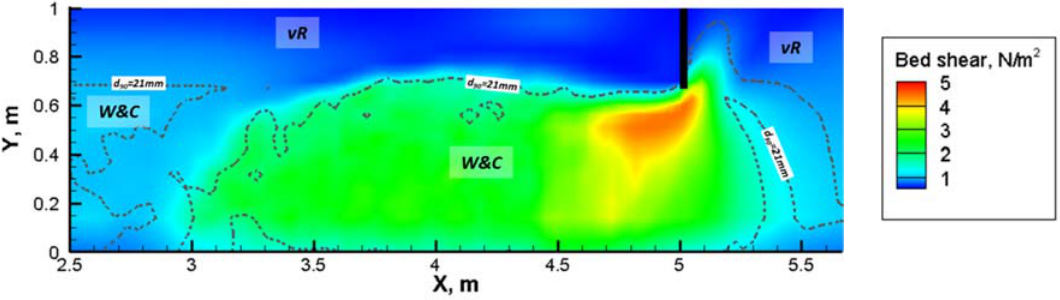
Figure 16. Equilibrium bed shear stress distribution and d 90 = 0.021 m isolines (dotted lines) at Q = 58 L/s, resulting from the combined approach.